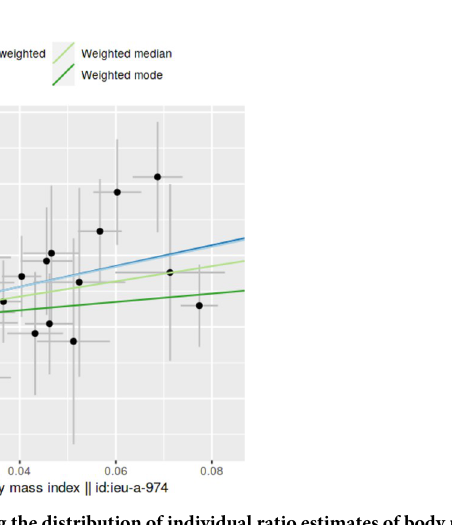
Fig 2. Scatter plot illustrating the distribution of individual ratio estimates of body mass index with polycystic ovarian syndrome as the outcome. Trend lines from the four different two-sample Mendelian randomization methods employed indicating the positive causal associations, are also included in each scatter plot.